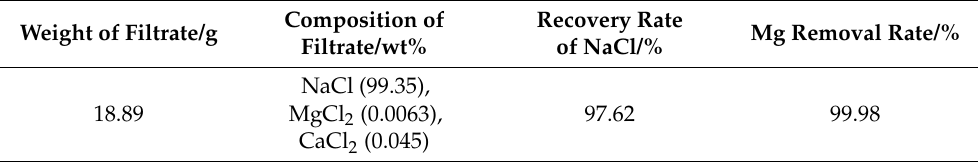
Table 5. The filtrate of molten salt chloride slag from Panxi. Weight of Filtrate/g